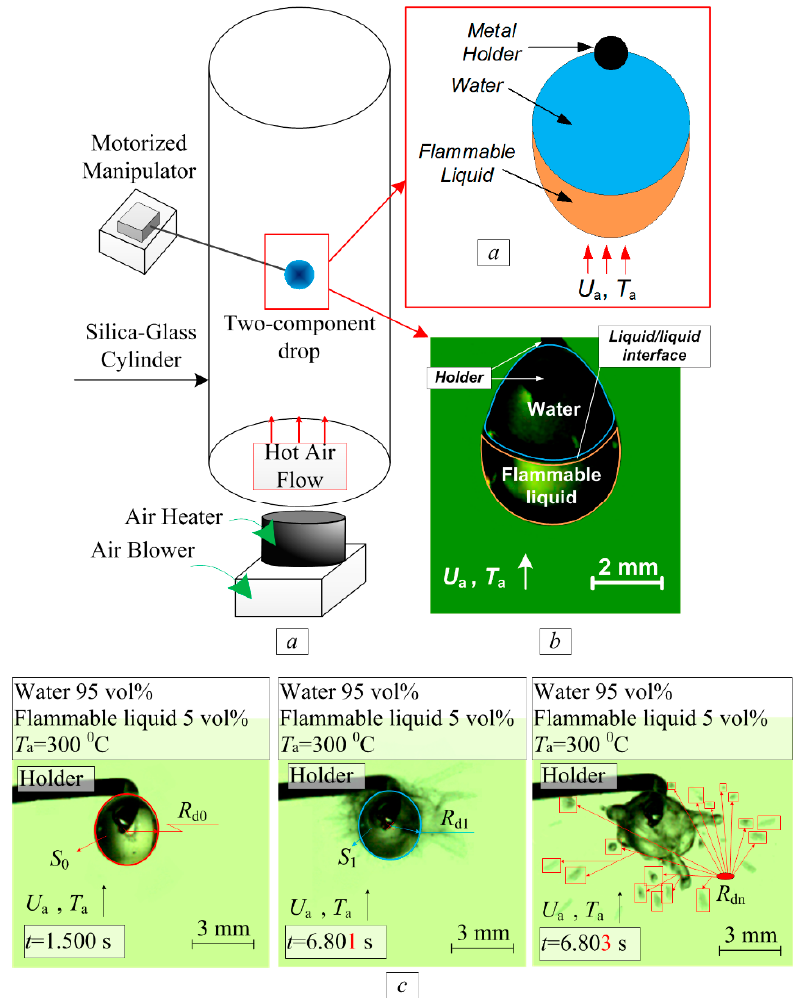
Figure 2. Methods for studying the disintegration of boiling droplets: ( a ): The scheme of registration of the heating process of two-component droplet; ( b ): Photo of the formed two-component droplet; ( c ): Scheme of recording heated droplet breakup and aerosol generation.